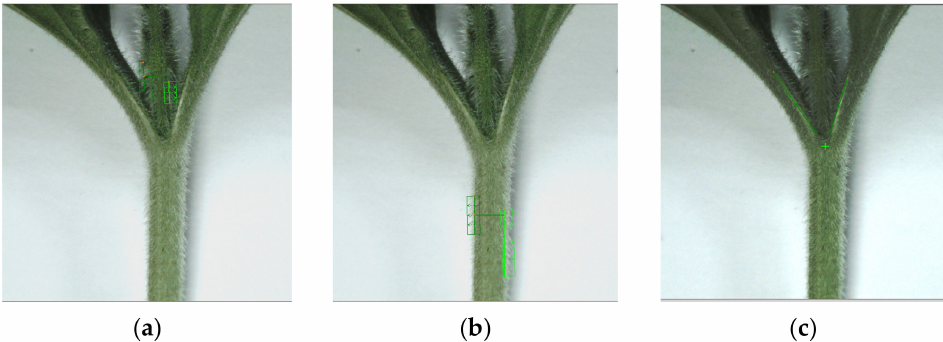
Figure 7. Measuring the morphological features of the seedling: ( a ) measuring features of the growing point, ( b ) measuring features of seedling stem, and ( c ) calibrating intersection features of cotyledons.